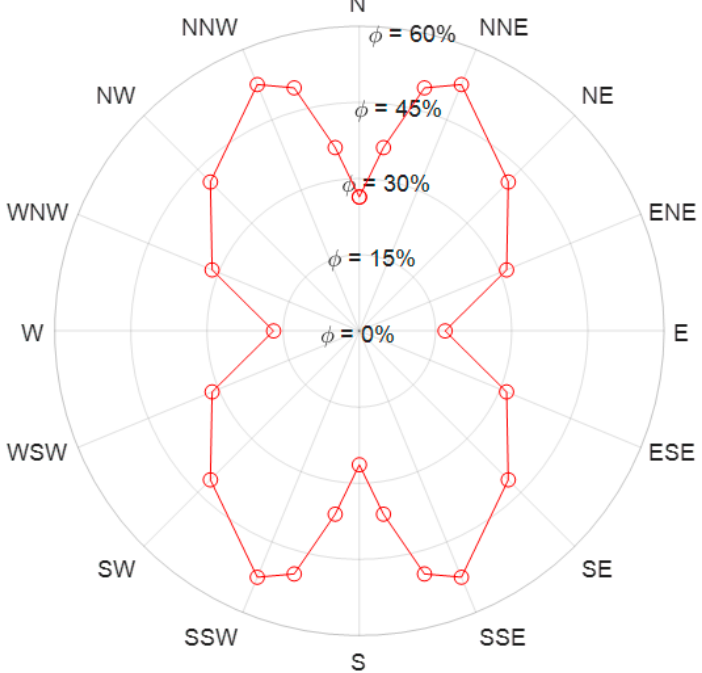
Figure 13. Global recirculation at the intakes of the evaporators, uniform